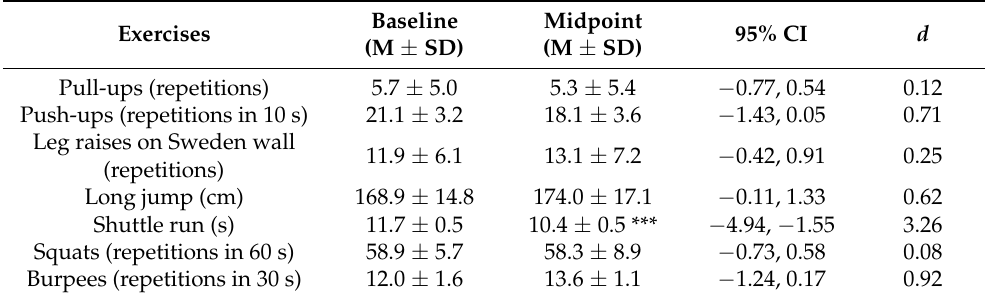
Table 2. Changes in physical fitness of 10–12-year-old judokas in the control group from baseline to mid-point test ( n = 9).